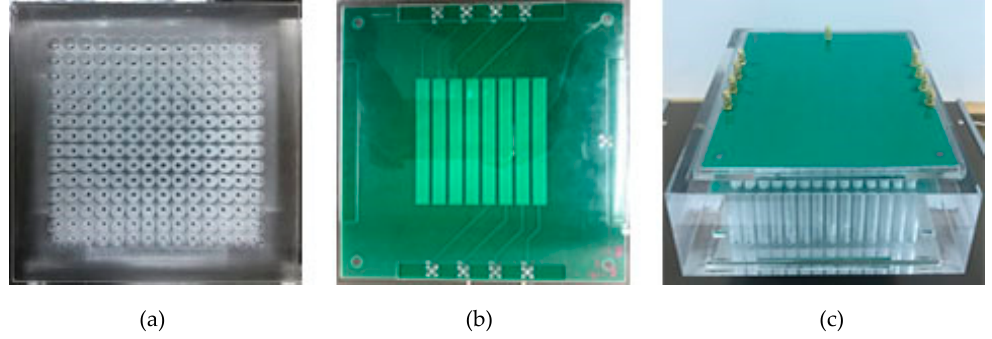
Figure 7. The experimental setup.